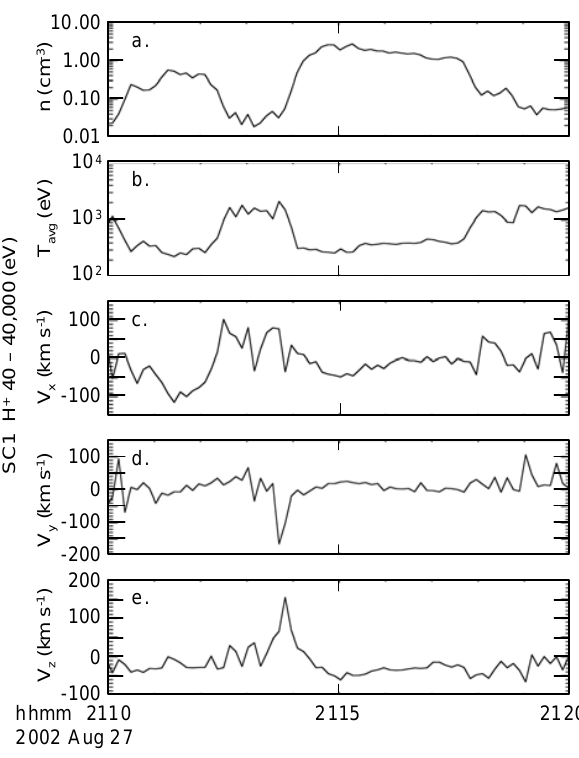
Fig. 7. Velocity moments (40-40,000 eV) of the first two flux structures in Figure 2d: (a) density, (b) thermal energy, and (c)-(e) bulk velocity components v x , v y , and v z , respectively. Figure 5 bears out this scenario with multiple